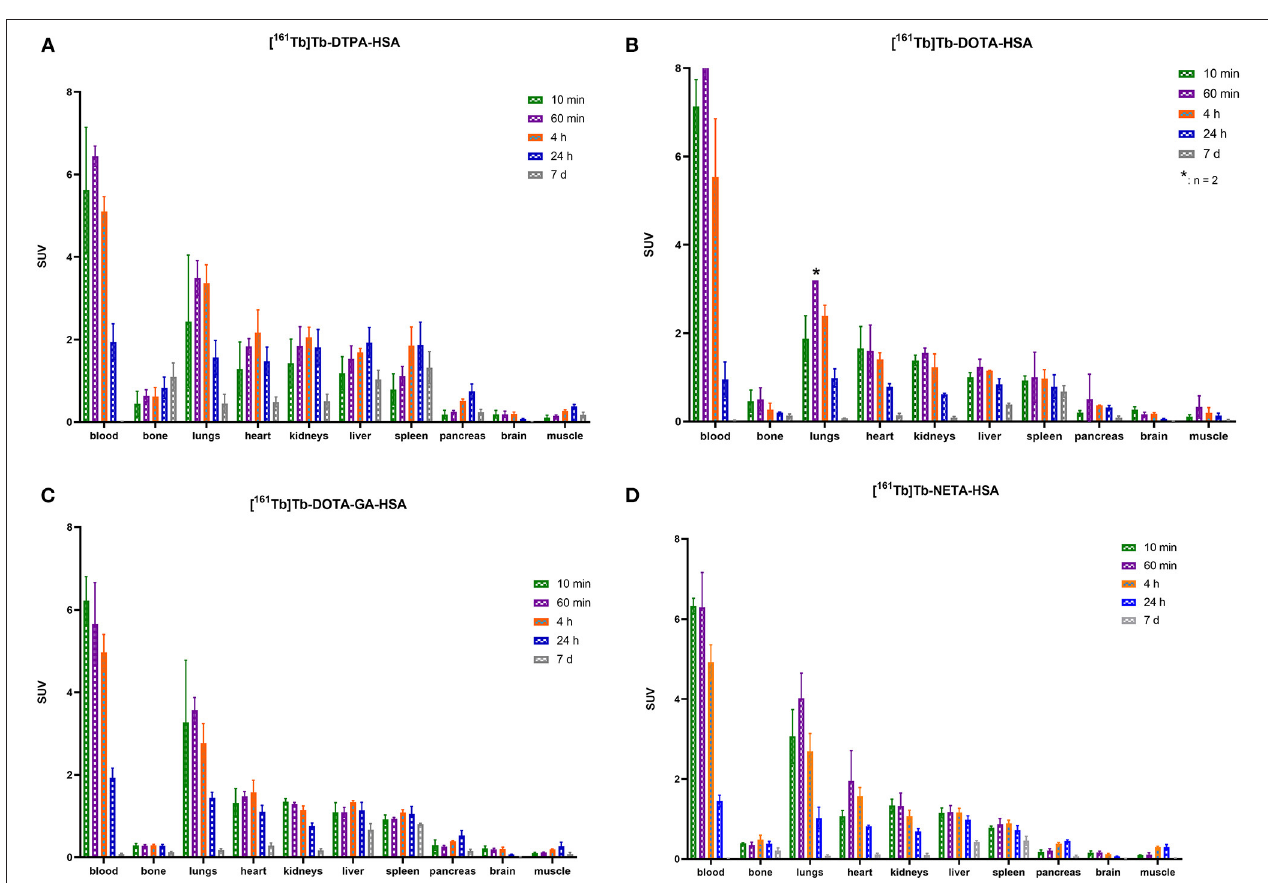
FIGURE 6 | Biodistribution of [ 161 Tb]Tb- DTPA -HSA (A) , [ 161 Tb]Tb- DOTA -HSA (B) , [ 161 Tb]Tb- DOTA-GA -HSA (C) and [ 161 Tb]Tb- NETA -HSA (D) expressed in standardized uptake values per organ (* n = 2).